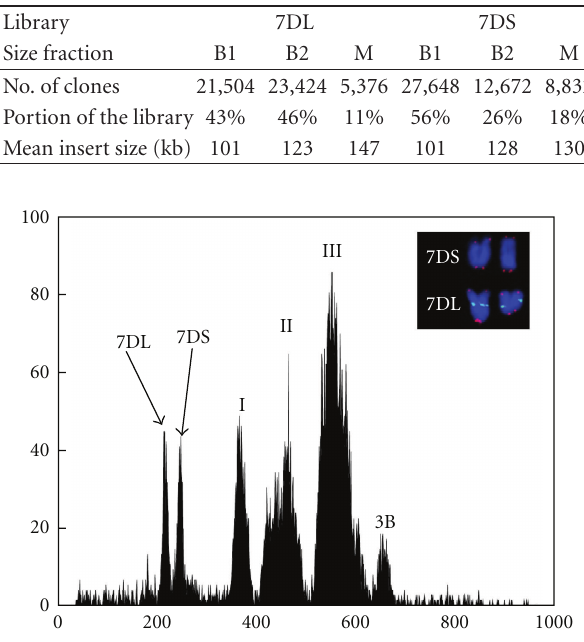
Figure 1: Histogram of relative fluorescence intensity (flow kary- otype) obtained after the analysis of DAPI-stained suspension of mitotic metaphase chromosomes prepared from double ditelo- somic line 7D. The inset shows examples of flow-sorted 7DL and 7DS telosomes after FISH with probes for the telomeric repeat (red color) and the GAA repeat (turqoise color), which were used to identify the telosomes in the sorted fractions and estimate their purities.